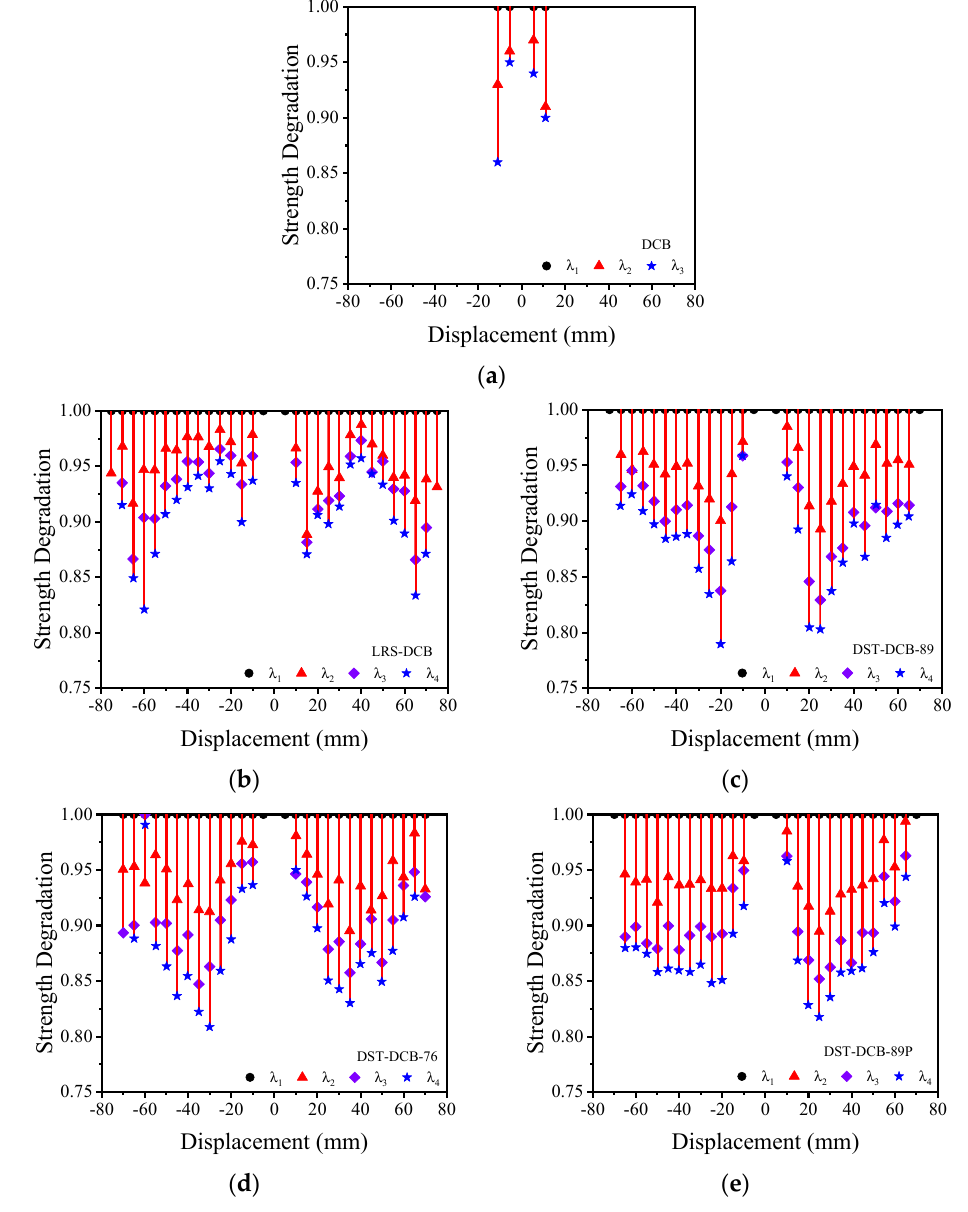
Figure 12. Strength degradation of all specimens: ( a ) DCB; ( b ) LRS-DCB; ( c ) DST-DCB-89; ( d ) DST-DCB-76; ( e ) DST-DCB-89P.